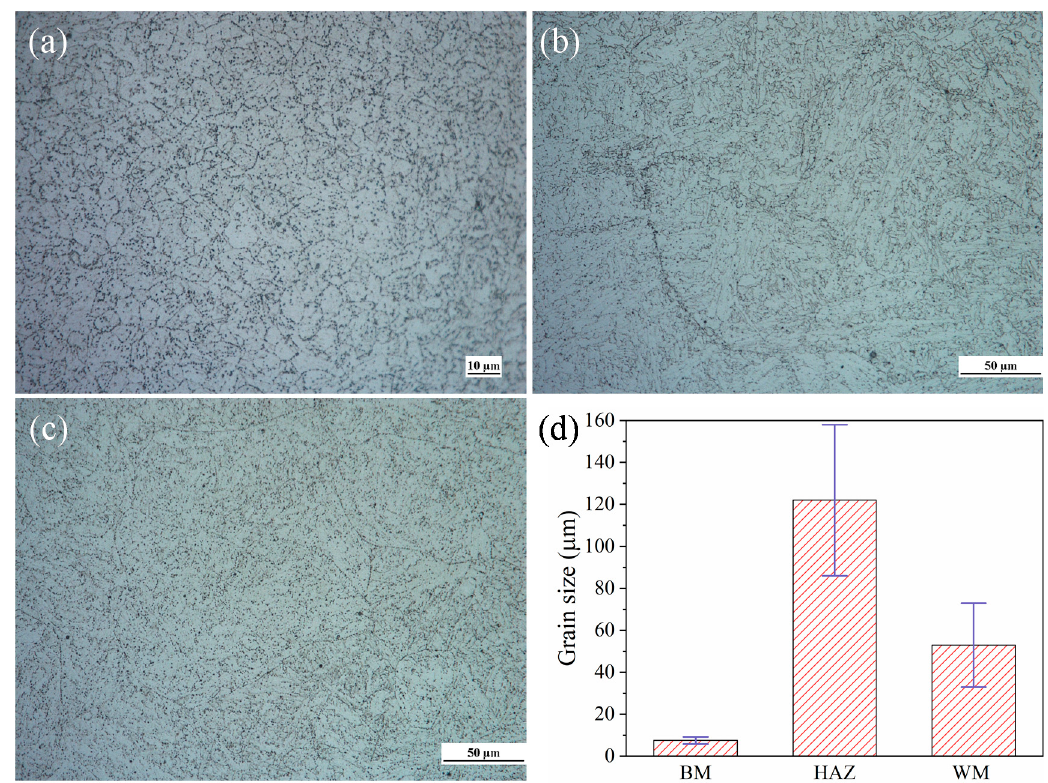
Figure 2. Microstructures of the 2.25Cr1Mo0.25V steel welded joint for ( a ) base metal (BM), ( b ) heat affected zone (HAZ) and ( c ) weld metal (WM), and ( d ) grain size distribution of different zones. Note that the scale bar in ( a ) BM is 10 μ m, while in ( b ) HAZ and ( c ) WM is 50 μ m. The error bars in ( d ) represent the standard deviation.